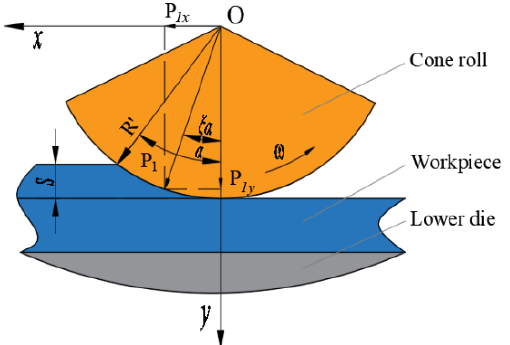
Figure 6. Mechanical model of stable rolling of the workpiece.